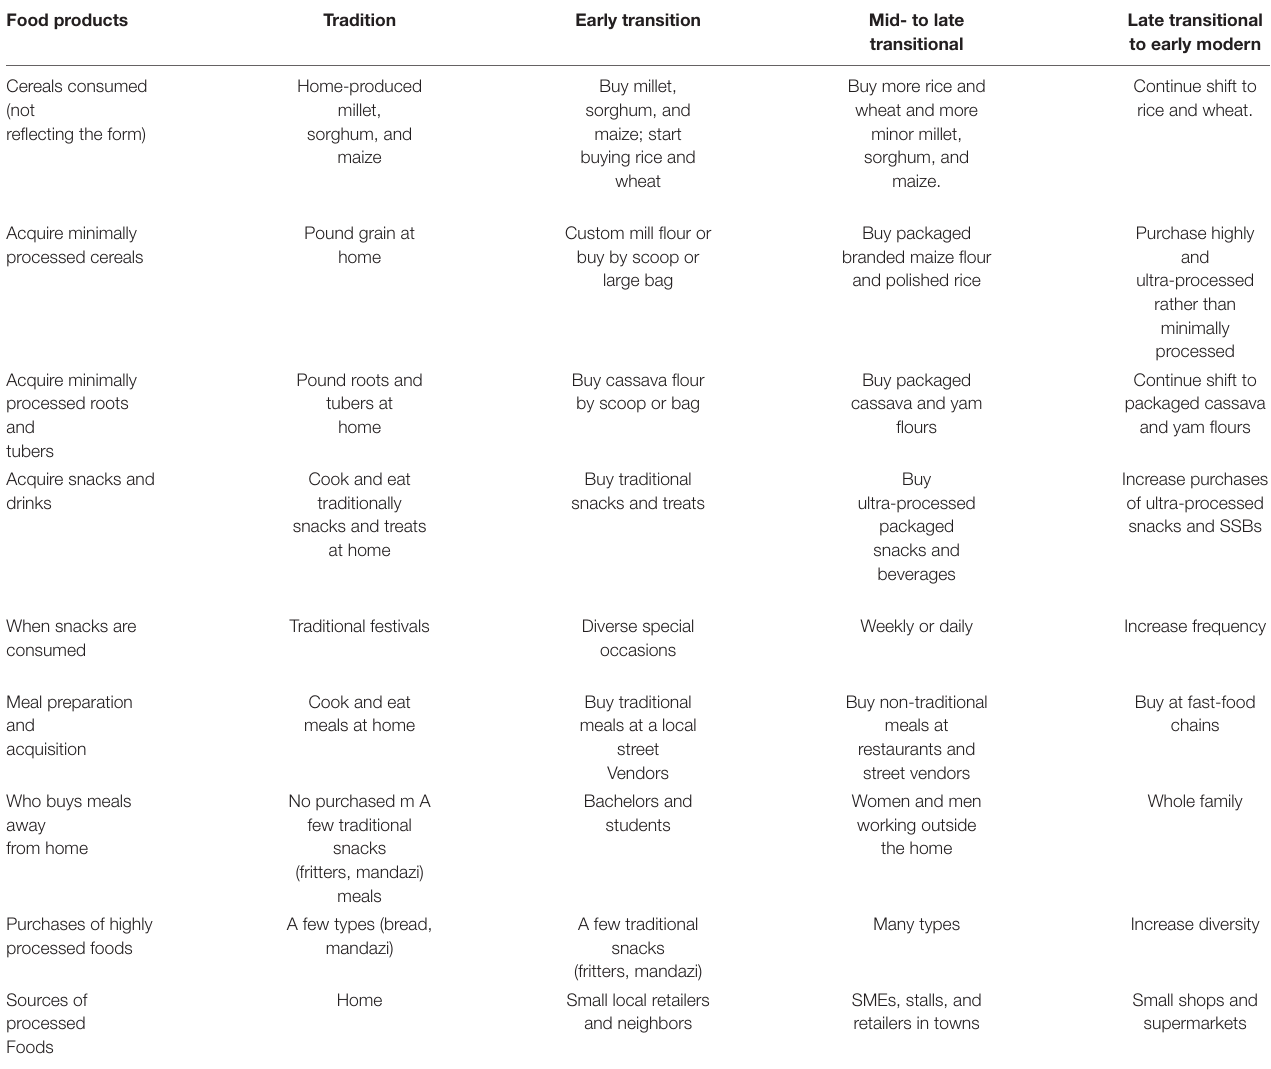
TABLE 2 | Overview of 11 critical shifts in the 50-year evolution of processed food consumption in sub-Saharan Africa: who, what, when, where, and